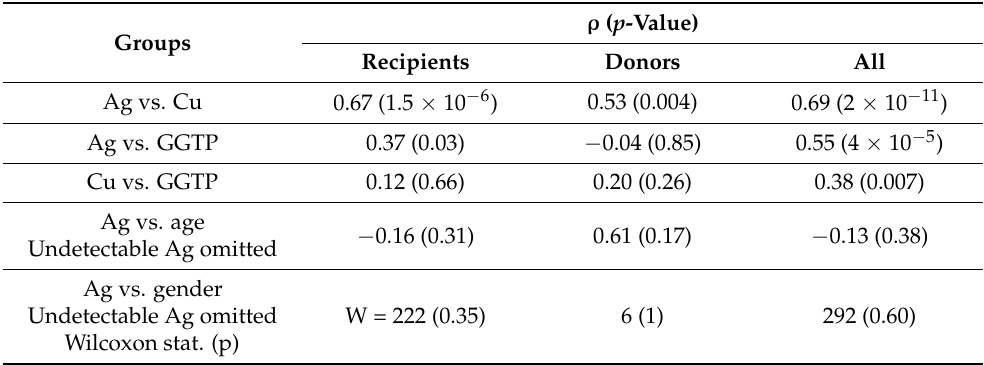
Table 1. Pairwise Spearman correlation ρ coefficient and associated p-value calculated for serum gamma- glutamyl transpeptidase (GGTP), liver copper and silver, age and gender in Donors and